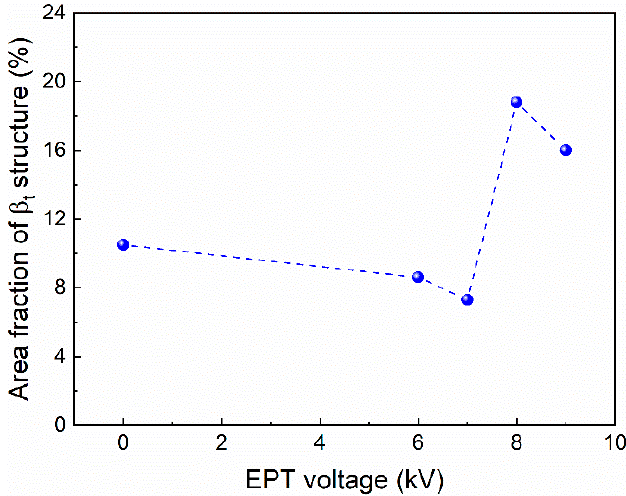
Figure 5. Evolutions of the bimodal structure inside wide bands in EPT samples: ( a ) EPT6, ( b ) EPT7, ( c ) EPT8, ( d ) EPT9.